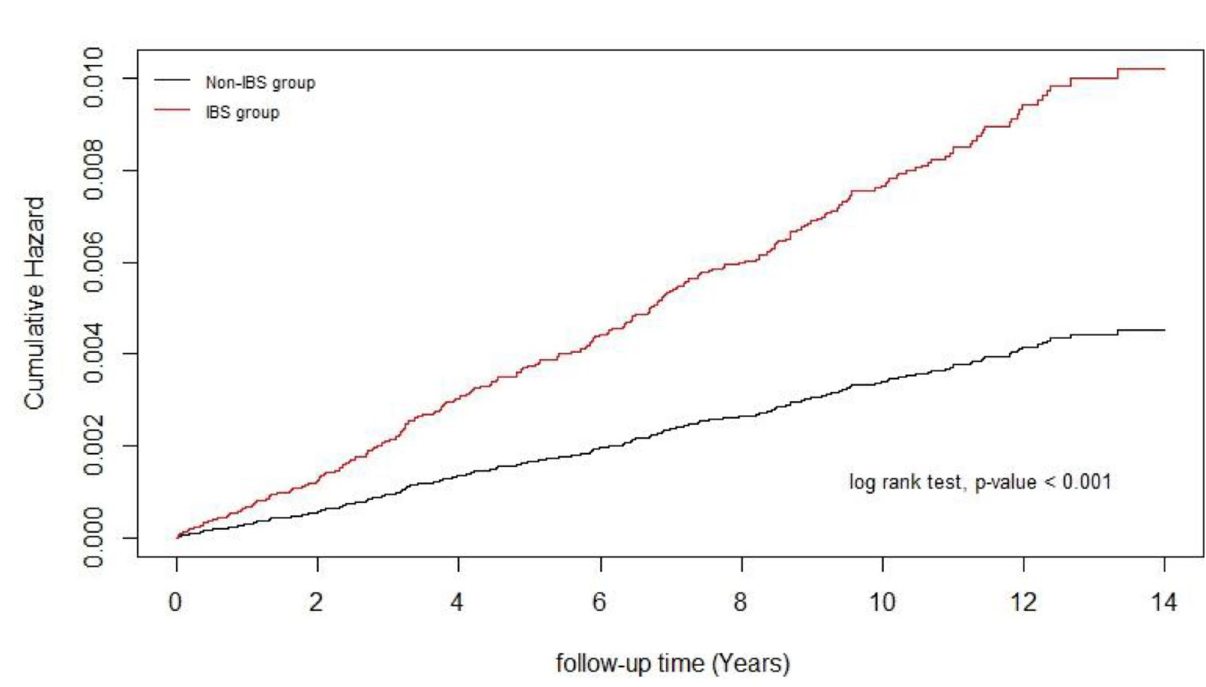
Fig 1. Cumulative incidence of RLS in the IBS and non-IBS groups, compared with a log-rank test. A statistically significant difference exists between the IBS and non-IBS groups ( p < 0.001).